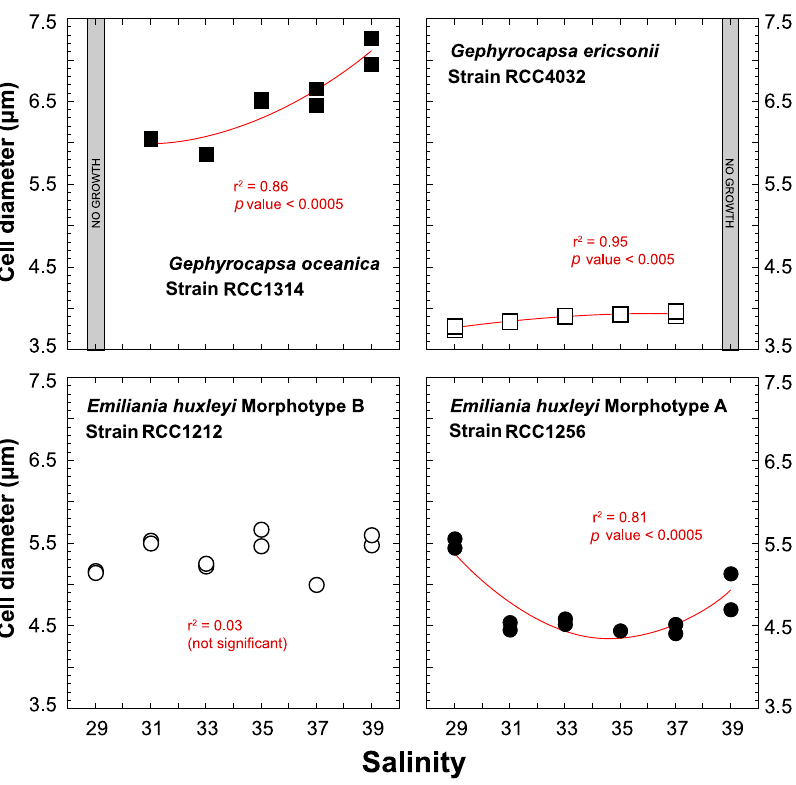
Figure 3. Effect of ambient salinity on the cell diameters of coccolithophore algae. As for growth rate, variations in the size of the cells (lightly decalcified coccospheres – see Methods) are species and strain dependent. All fits (red lines) correspond to a second-order polynomial law.